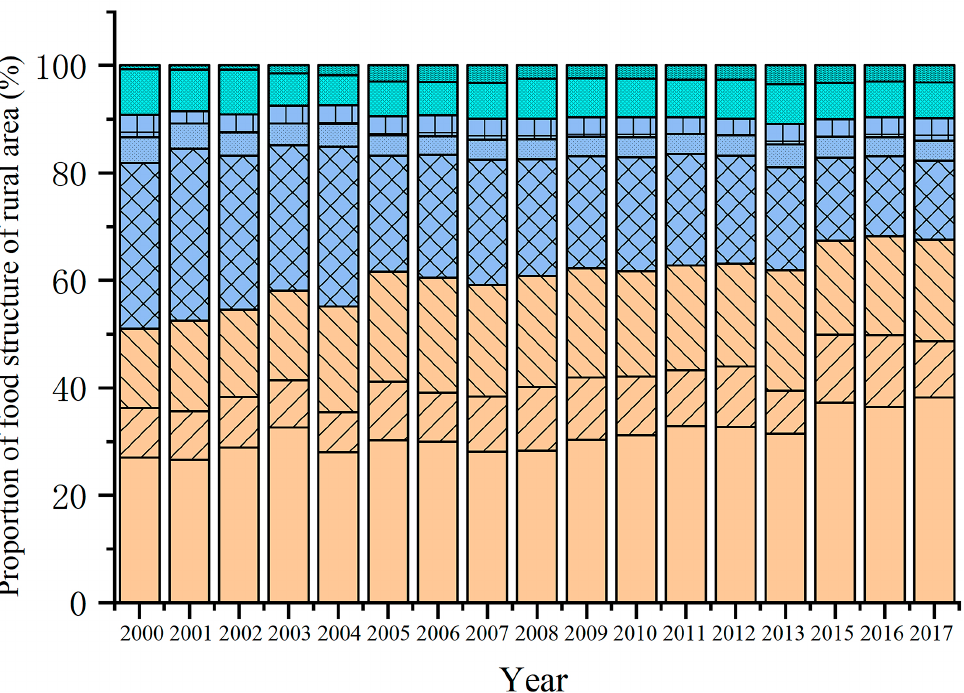
Figure 5. Changes in the proportion of various food N footprints in the urban and rural areas of Shanghai from 2000 to 2017. The food N footprints were analyzed by weight (kg N/capita/yr).